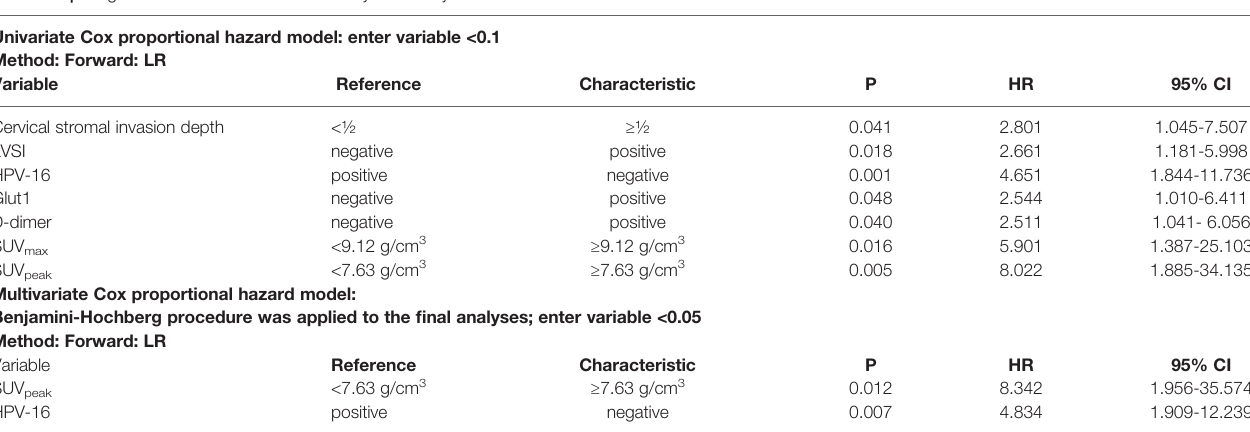
TABLE 3 | Prognostic factors for DFS selected by Cox